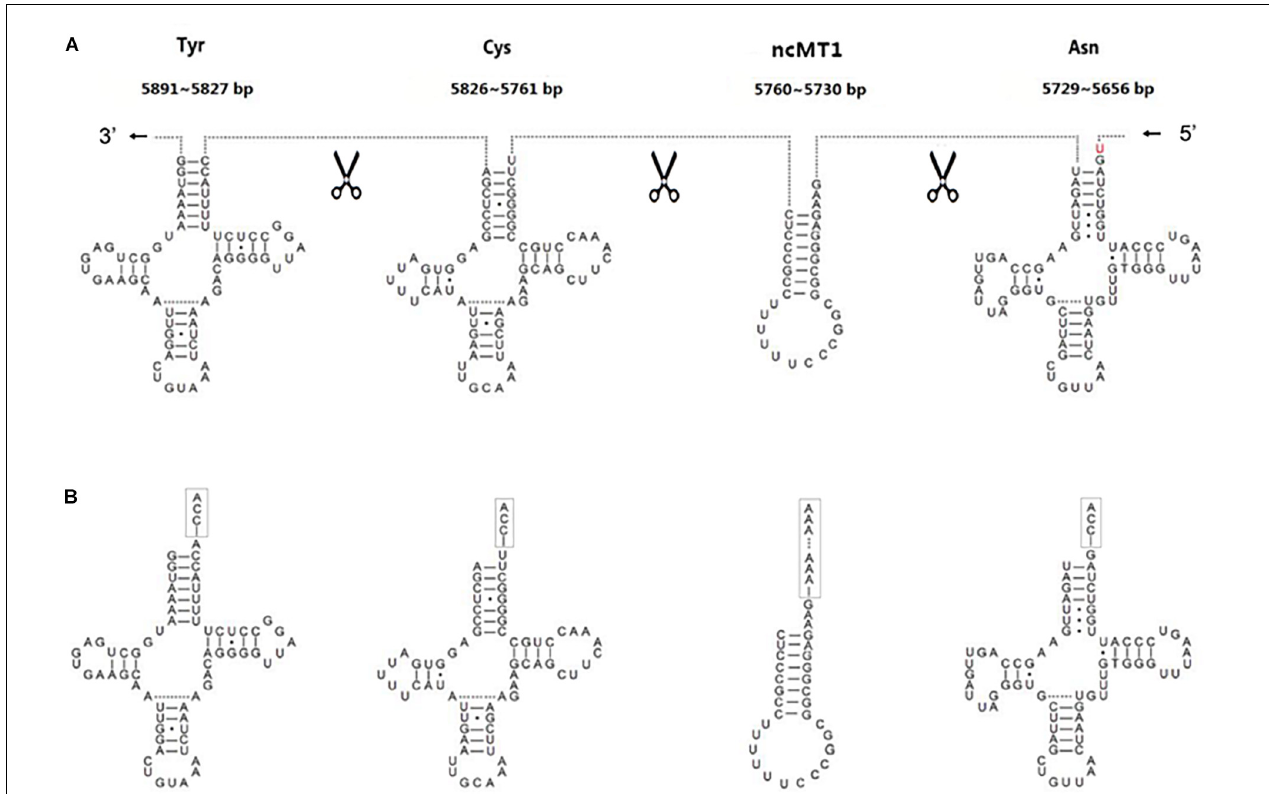
FIGURE 3 | Corrected annotations of mitochondrial tRNAs. tRNA Tyr /tRNA Cys /tRNA Asn /tRNA Ala is encoded by L-strand of human mitochondrial genome. tRNA Ala is not showed, as it does not need correction. ncMT1 was first discovered in this study. (A) Mitochondrial tRNAs are annotated between two cleavage sites using the sRNA-seq based method, while they are annotated between two trimming sites and several nucleic acids in red color are missed using other existing methods. (B) The acceptor stem of a tRNA precursor is trimmed to contain a 1-bp overhang at the 3 (cid:48) end. CCAs are post-transcriptionally added to the 3 (cid:48) ends of tRNAs, one nucleotide at a time. A polyA tail is post-transcriptionally added to the 3 (cid:48) end of ncMT1.